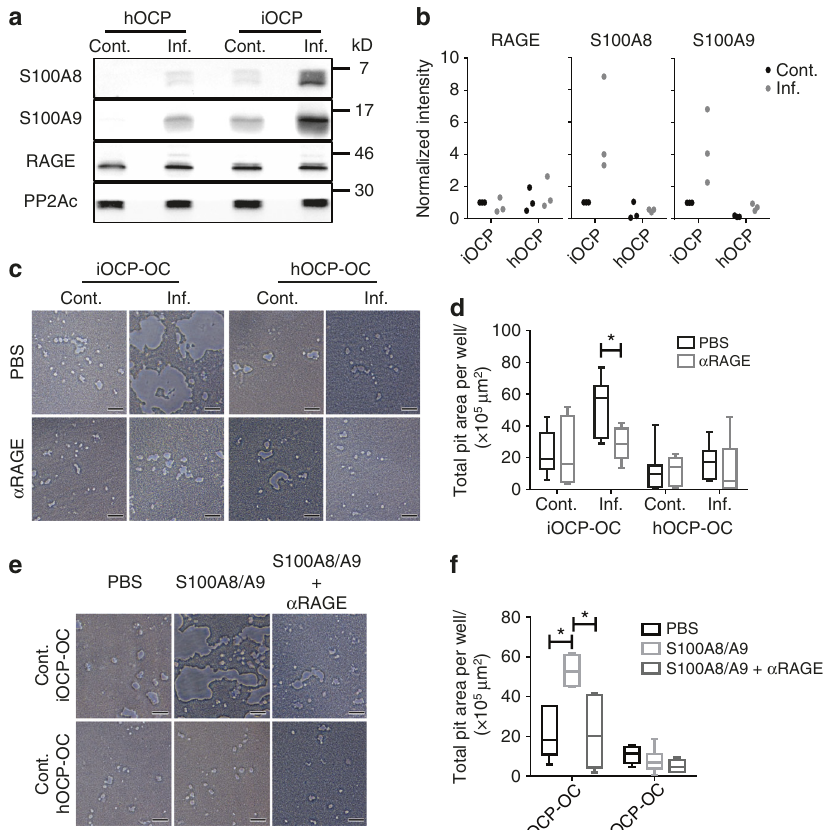
Fig. 7 S100A8/A9 proteins augment differentiation and osteoclastic activity derived from iOCPs but not from hOCPs. a Expression of S100A8, S100A9 and RAGE in sorted control and in fl amed BM iOCPs and hOCPs. The protein phosphatase 2A catalytic subunit (PP2Ac) is shown as a loading control. b Densitometry measurements of three biological repeats (no statistical analysis presented). c Sorted control and in fl amed BM iOCPs and hOCPs (5 × 10 4 ) were cultured on the Osteo assay surface with or without anti-RAGE blocking antibodies (bar: 50 µm). d Pit area quantitation. e Sorted iOCPs and hOCPs (5 × 10 4 ) from the BM of control mice were cultured on the Osteo assay surface in combination with a recombinant S100A8/A9 heterodimer and anti-RAGE blocking antibodies as indicated (bar: 50 µm). f Pit area quantitation. c – f Depict representative results for two independent experiments, n = 5 for each group. Line: median, box: 25th-75th percentile, whiskers: range. * P < 0.05 (Mann – Whitney test and Holm multiplicity blockade of S100A8, S100A9 and RAGE in OC cultures of iOCPs and OCs, with OC-speci fi c CTSK exhibiting the highest expression (Fig. hOCPs isolated from in fl amed BM to determine the involvement of 6f, right panel). Together, these data show that iOCP-OCs are more each protein in osteoclastogenesis. While blocking S100A8 or active than hOCP-OCs, in both metabolism and bone resorption. S100A9 separately did not affect the osteoclastogenesis of iOCPs or hOCPs, simultaneous blockade of S100A8 and S100A9 and/or S100A8/A9 proteins augment differentiation of iOCPs but not that RAGE inhibited the OC formation of only iOCPs, not that of hOCPs of hOCPs toward highly active osteoclasts (Fig. S6a, b). Blocking RAGE abrogated the enhanced resorption To elucidate the mechanism underlying the response of iOCPs to observed in in fl amed iOCP cultures but did not affect that in control in fl ammatory signals that lead to the differentiation of OCs with high iOCP cultures or cultures of hOCPs from in fl amed or control mice resorptive activity, we focused on key proteins belonging to the (Fig. 7c, d). Since iOCPs but not hOCPs express endogenous S100A8/ in fl ammatory signature obtained when analyzing in fl amed iOCPs. A9, we further tested whether control iOCPs and hOCPs can respond The S100A8/A9 proteins were chosen due to their signi fi cant to exogenously added S100A8/A9 with enhanced OC activity. contribution to the in fl ammatory component (PC2) (Fig. 4d), their Control iOCPs generated iOCP-OCs with enhanced activity in abundant expression in in fl amed iOCPs (Fig. 4f), and their known role response to S100A8/A9, and this effect was abrogated by RAGE in the regulation of in fl ammatory processes and the immune blockade, while control hOCPs did not respond to S100A8/A9 or response 20 . Analyzing the expression levels of these proteins in the RAGE blockade (Fig. 7e, f). Taken together, these results show that different OCP subpopulations revealed that only iOCPs substantially only iOCPs respond to autocrine and exogenous S100A8/A9 via increased S100A8/A9 expression during chronic in fl ammation, while RAGE by differentiating into highly resorptive OCs and that this control and in fl amed hOCPs exhibited low expression of these interaction does not affect hOCPs. proteins (Fig. 7a, b). The receptor for S100A8/A9, RAGE, was found to be equally expressed by both OCP populations in in fl amed and Reduced accumulation of iOCPs but not hOCPs in in fl amed control mice. Protein phosphatase 2A catalytic subunit (PP2Ac) was tnf- α − / − mice correlates with attenuated IBL used as a loading control. We further tested whether the RAGE-S100A8/A9 axis affects the We have previously shown that during chronic in fl ammation, TNF- α is the master regulator of myelopoiesis and functions by differentiation of iOCPs and hOCPs into OCs. We used combinatorial